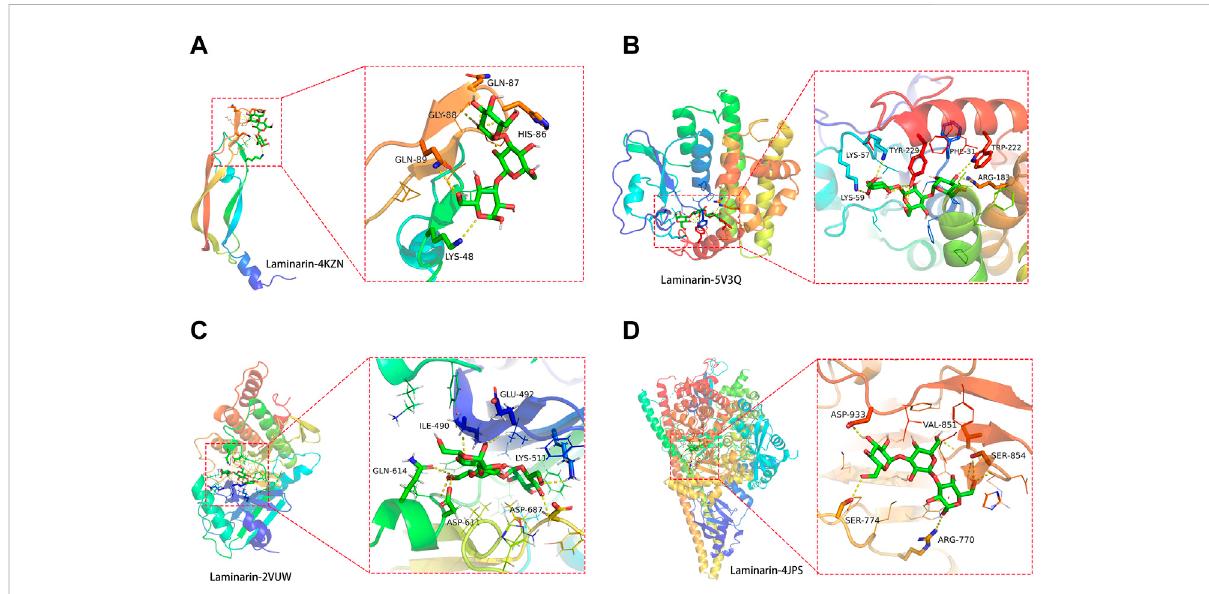
FIGURE 4 Direct binding of laminarin with its target proteins. Molecular docking analysis showed the hydrogen bond formation between laminarin with the amino residues of (A) VEGFA (ID: 4KZN), (B) TLR4 (ID: 5V3Q), (C) CASP8 (ID: 2VUW), and (D) PIK3R1 (ID: